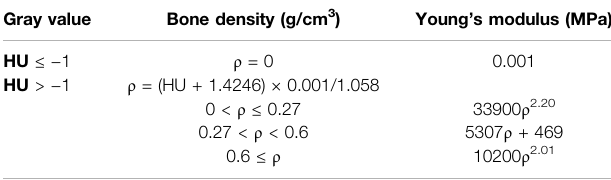
TABLE 2 | Formulas describing the transformation from gray value to elastic